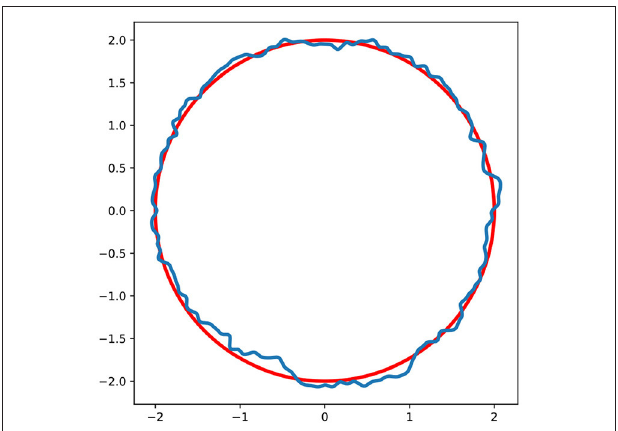
FIGURE 2 | Surface roughness generation. Red line is an initial surface of the particle. Blue line is a surface of a particle with generated roughness.